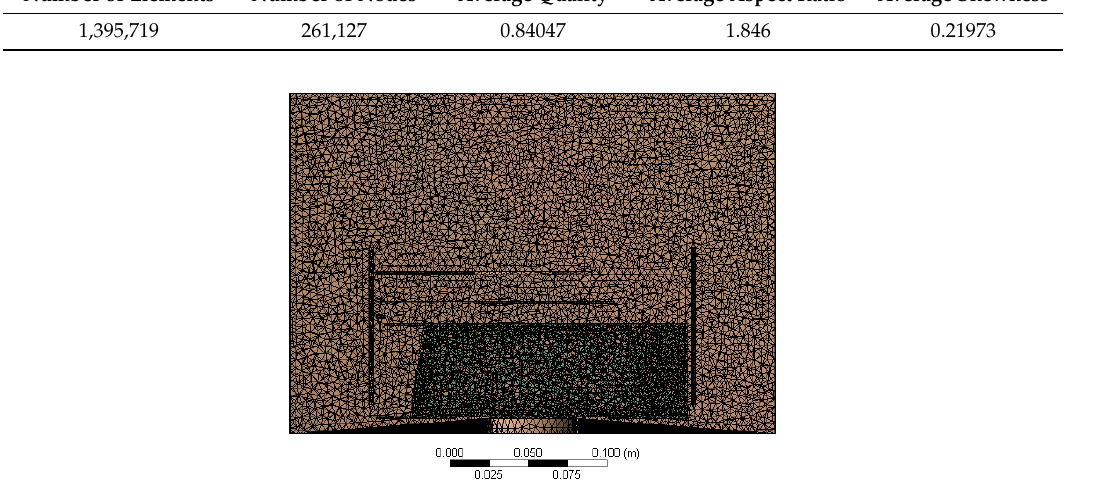
Table 1 . Main mesh parameters. Figure 3 . Mesh cross section. Figure 3. Mesh cross